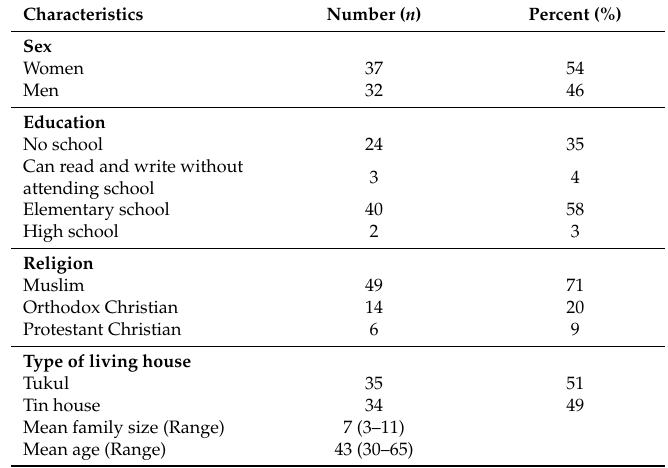
Table 1. Background characteristics of focus group discussion